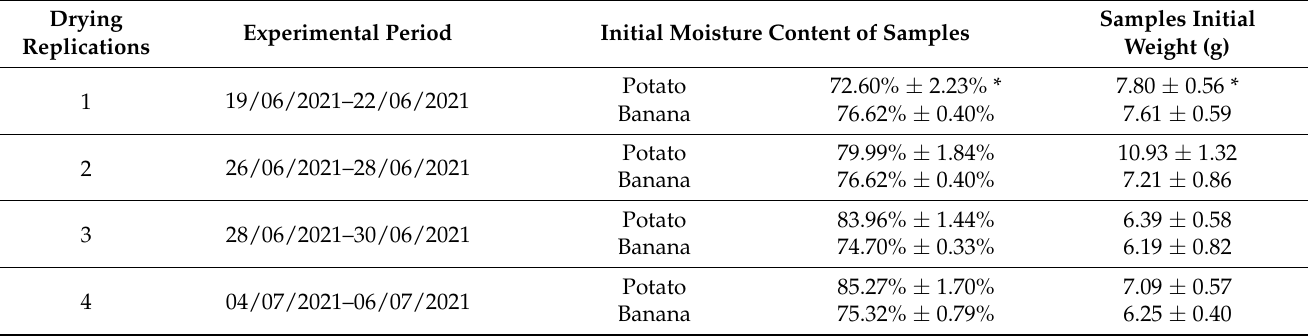
Table 3. Brief description of the experimental period and sample characteristics.